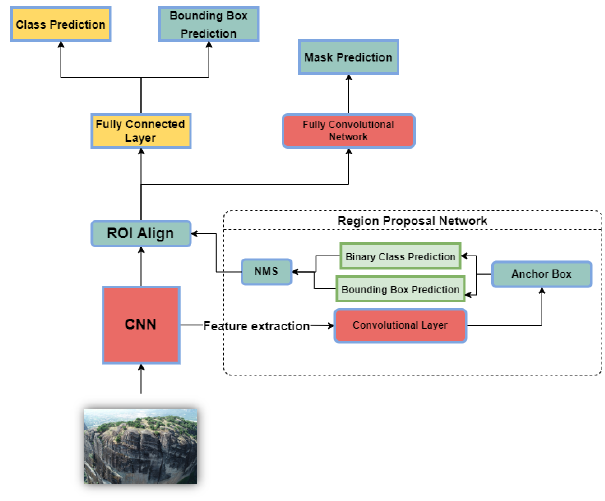
Figure 1: Architecture of the Mask-R